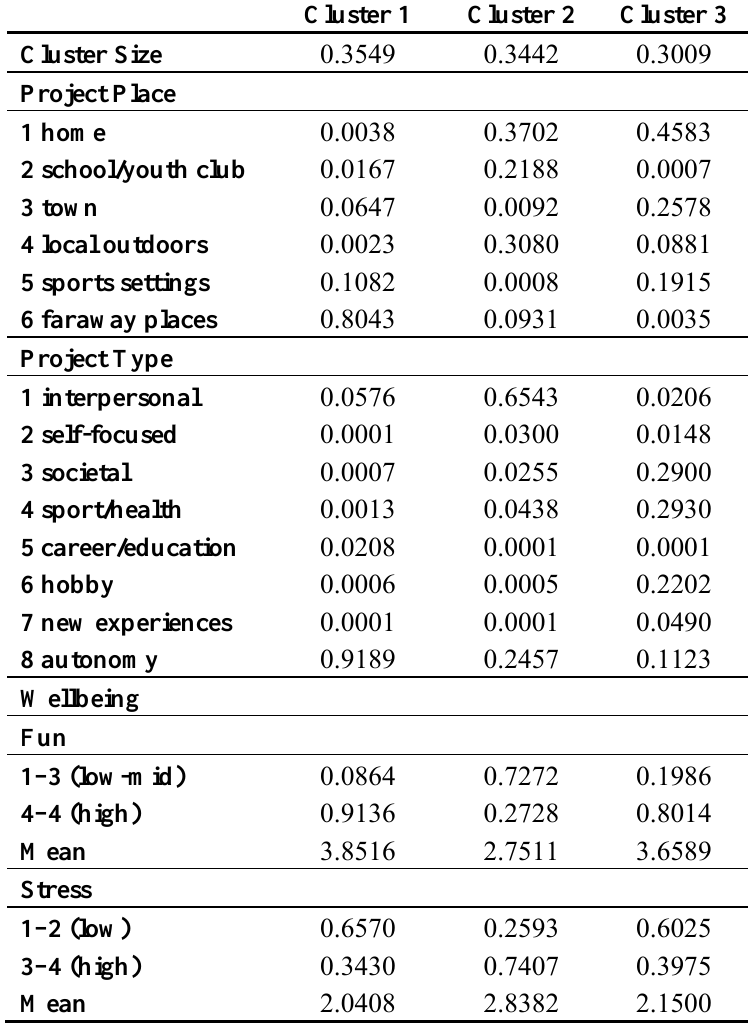
Table 5. Latent Class